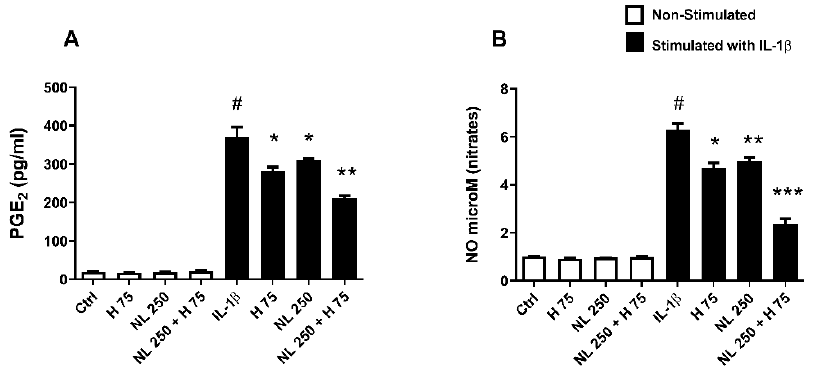
Figure 7. Influence of hop extract, empty nanoliposomes, and nanoliposomes encapsulating hop extract on inflammation marker release in vitro. Human chondrocytes were stimulated or not with 1 ng/mL IL-1 β and exposed to hop extract alone (75 µ g/mL), empty nanoliposomes (250 µ g/mL rapeseed lecithin), or nanoliposomes encapsulating hop extract (at 250 µ g/mL rapeseed lecithin and 75 µ g/mL hop extract). The culture conditions were performed for 48 h. The release of ( A ) PGE 2 was quantified by ELISA, and the production of ( B ) NO was assessed by the Griess reaction. Ctrl—control cells, meaning chondrocytes not treated with hop extract alone, empty nanoliposomes, or nanoliposomes encapsulating hop extract; ELISA—enzyme-linked im- munosorbent assay; H—hop extract alone; H 75—hop extract alone diluted to a final concentration of 75 µ g/mL; IL-1 β —interleukin-1 β ; NL—empty nanoliposomes; NL 250—empty nanoliposomes di- luted to a final lecithin concentration of 250 µ g/mL; NL + H—hop-extract-loaded nanoliposomes; NL 250 + H 75—nanoliposomes encapsulating hop extract diluted to a final lecithin concentration of 250 µ g/mL and a final hop concentration of 75 µ g/mL; NO—nitric oxide; PGE 2 —prostaglandin E 2 ; SD—standard deviation. The reported data are represented as mean ± SD of at least four individual experiments. Significance compared to Ctrl is indicated as # for p < 0.01. Significance compared to cells stimulated by IL-1 β alone is indicated as * for p < 0.01, ** for p < 0.001, and *** for p <